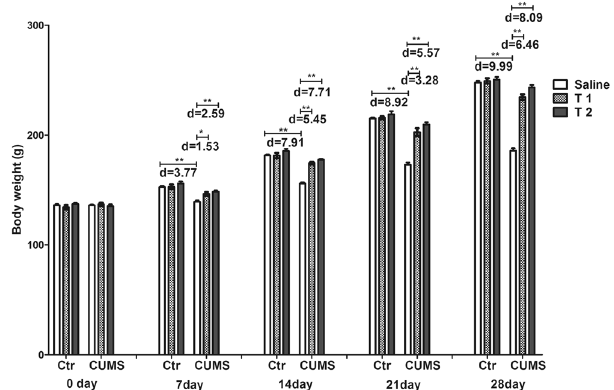
Figure 1. Effects of taurine on the body weight. The body weight was recorded on days 0, 7, 14, 21 and 28 of CUMS were applied. Ctr, control group; CUMS, CUMS group; Saline, i.p. saline; T1, i.p. 200 mg/kg taurine; T2, i.p. 500 mg/kg taurine; All data are expressed as means ± SE and were analyzed by repeated measures ANOVA with group and time as factors followed by Bonferroni’s multiple comparisons post hoc test (n = 10). * P < 0.003 vs. CUMS group; ** P < 0.00067 vs. CUMS group. d means Cohen’s d, d = 0.20 was considered as small effect size, d = 0.50 was considered as medium effect size, d = 0.80 was considered as large effect